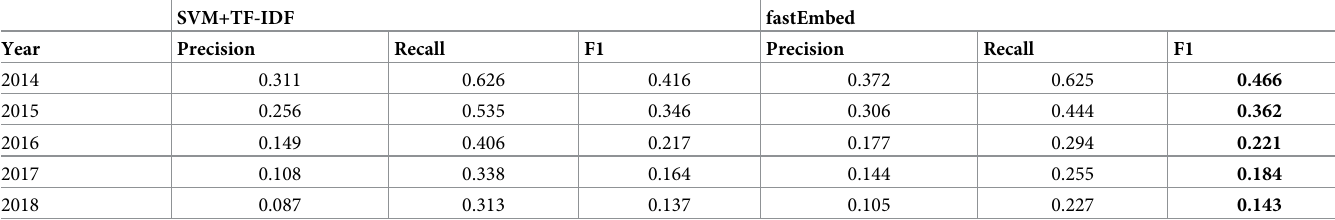
Table 9. Performance metrics for prediction by year using online